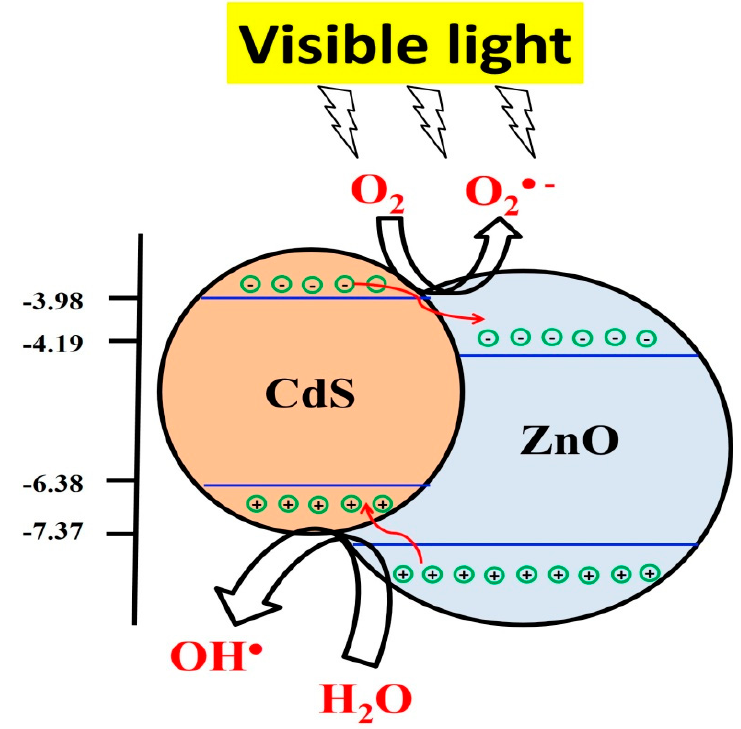
Figure 7. Schematic representation of the proposed mechanism for the photocatalysis of composite NFs.